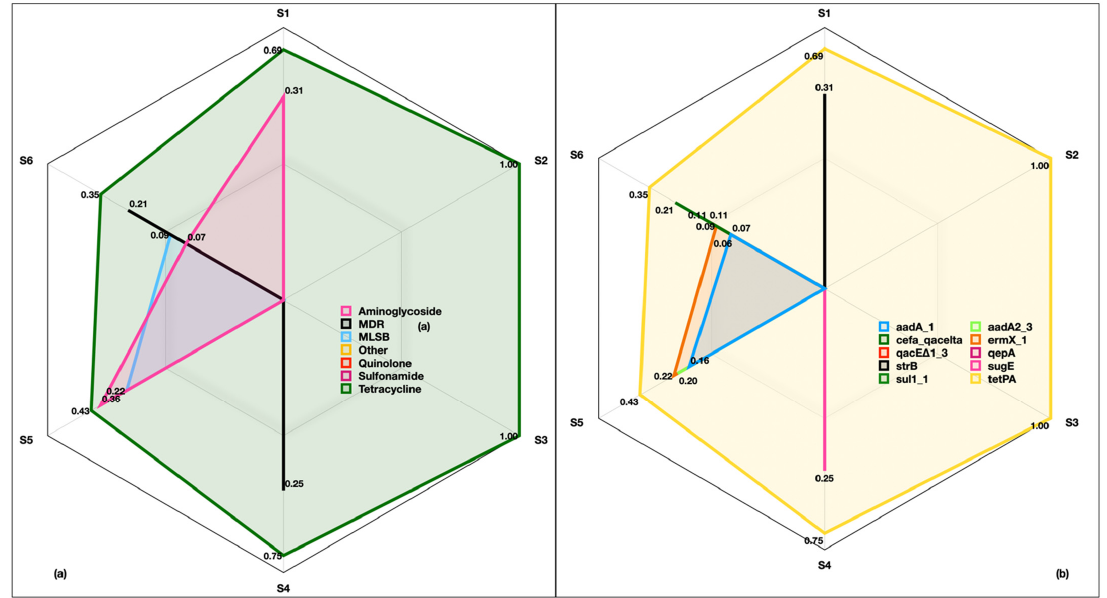
Figure 7. Antibiotic resistance genes in inhalable and respirable size fractions of indoor aerosols collected from HI-3 hospital in Kuwait. ( a ) Relative abundance of drug classes in six size fractions, ( b ) relative abundance of corresponding genes. S1 and S6 represent the six stages of Anderson cas- cade impactor with a pore size of 0.30 to 0.69 µm (base fi lter), >0.69 to 1.3 µm (Stage 5), >1.3 to 2.1 µm (Stage 4), >2.1 to 4.2 µm (Stage 3), >4.2 to 10.2 µm (Stage 2) and >10.2 µm (Stage 1).